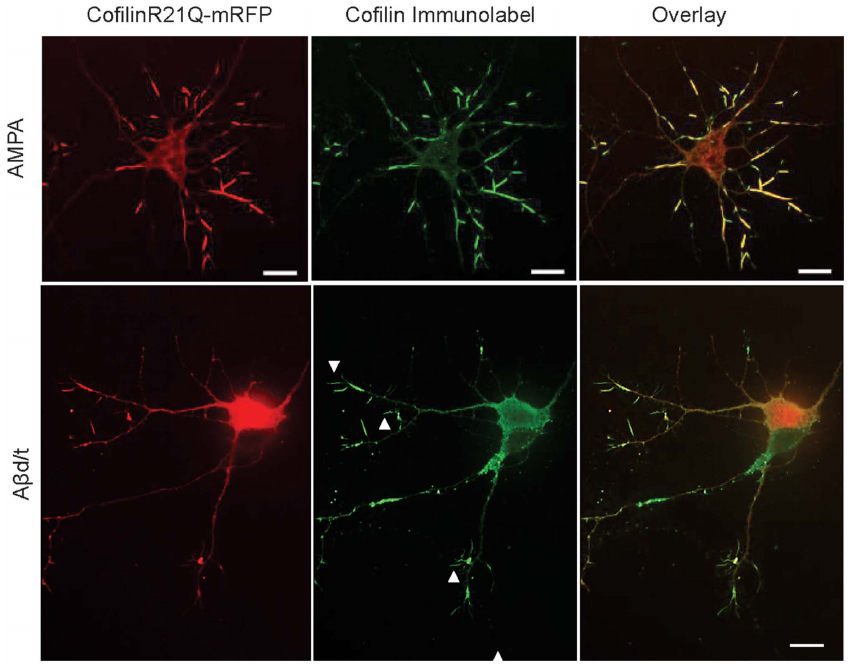
Figure 4. CofilinR21Q-mRFP incorporates into virtually all AMPA-induced rods, but only into half of rods in A b d/t-treated neuronal cultures. CofilinR21Q-mRFP fluorescence image, immunolabeled (Alexa 488) image, and overlay in neurons treated 30 min with 150 m M AMPA showing virtually all rods (immunolabel) have incorporated cofilinR21Q-mRFP. Similar results (not shown) were obtained for ATP-depleted neurons. CofilinR21Q-mRFP fluorescence image, immunolabeled image (Alexa 647 but colorized green), and overlay in neurons treated 24 h with A b d/t. Immunolabeled rods that incorporated cofilinR21Q-mRFP were quantified from many different cultures and co-labeled rods accounted for 48 6 4% (std. deviation) of the total rods. Immunolabeled rods that do not contain mRFP are shown by arrowheads. Scale bars =10 m